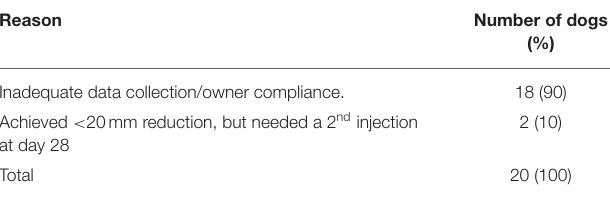
TABLE 2 | Reasons for patient